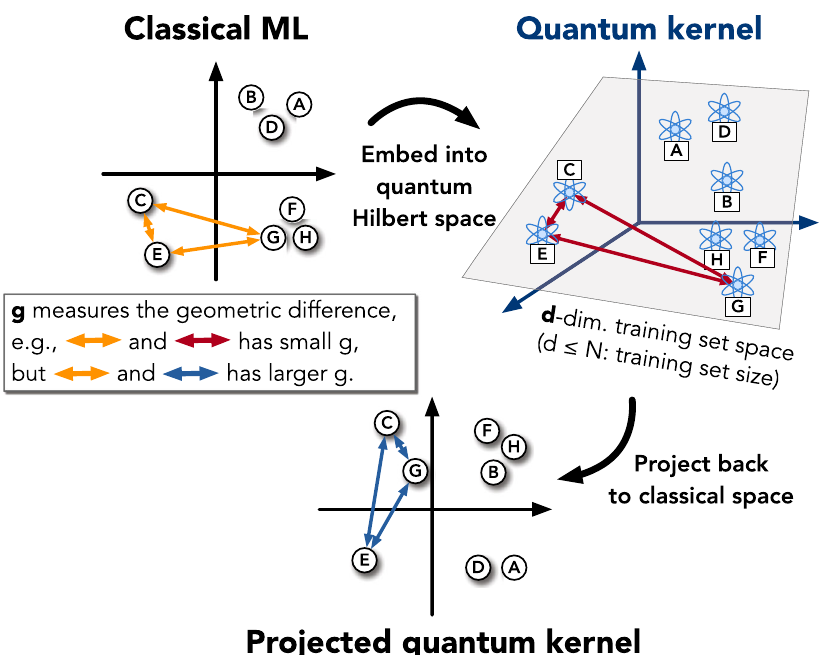
Fig. 2 Cartoon of the geometry (kernel function) de fi ned by classical and quantum ML models. The letters A, B, ... represent data points { x i } in different spaces with arrows representing the similarity measure (kernel function) between data. The geometric difference g is a difference between similarity measures (arrows) in different ML models and d is an effective dimension of the dataset in the quantum Hilbert